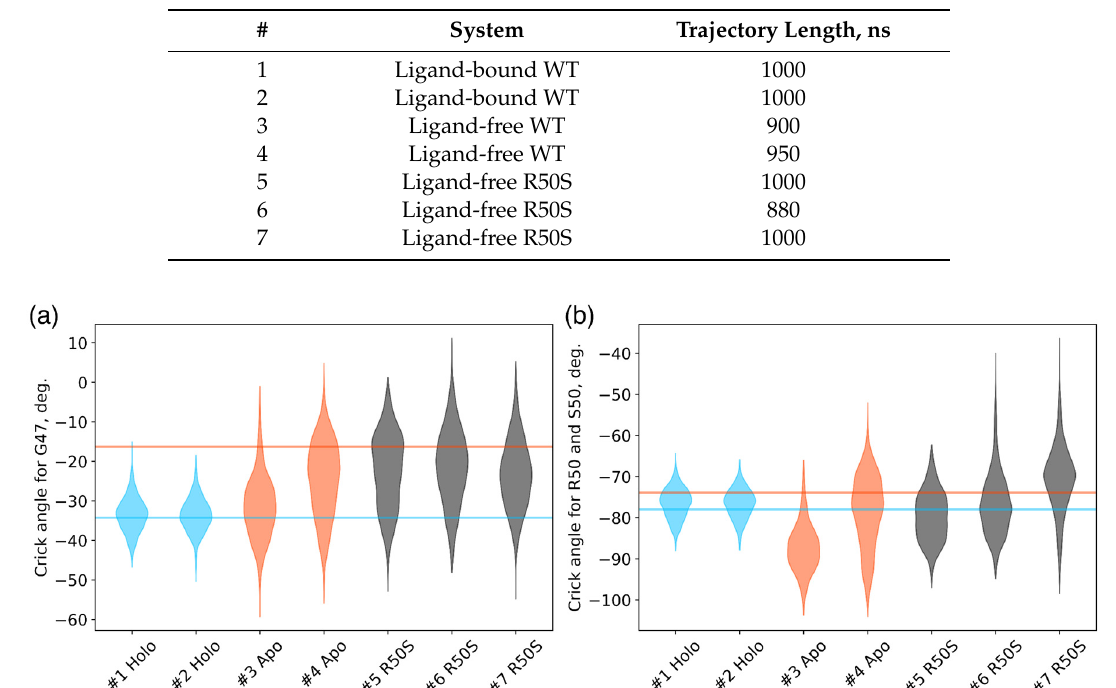
Figure 3. Crick angles for ( a ) Gly47 and ( b ) Arg50 or Ser50 in the last 200 ns of the simulations. Horizontal lines indicate the Crick angles in crystallographic structures, the values for the symmetric ligand-bound WT structure (PDB ID 5IJI) are shown in cyan, the values for the symmetric ligand-free WT structure (PDB ID 5JEQ) are shown in orange.